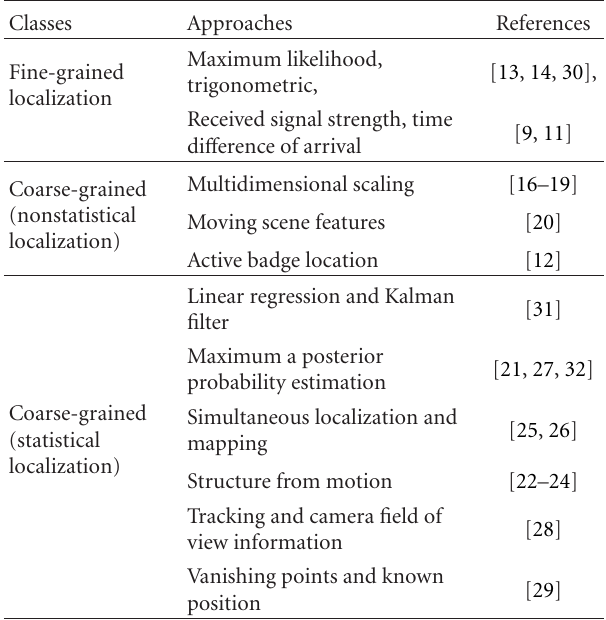
Table 2: Performance comparison between CLUTE , MAP , and MDS on the three datasets (4-camera